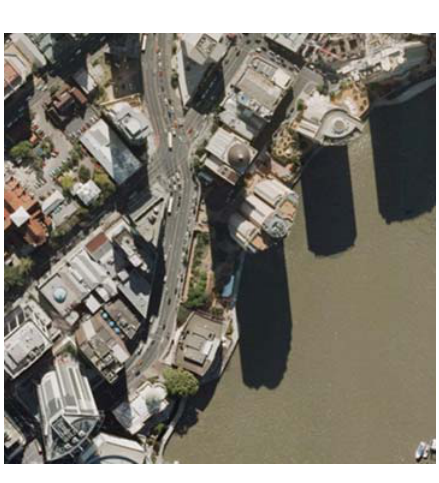
fter cut-line computation, the complete mosaic is computed ualization between images, lines.